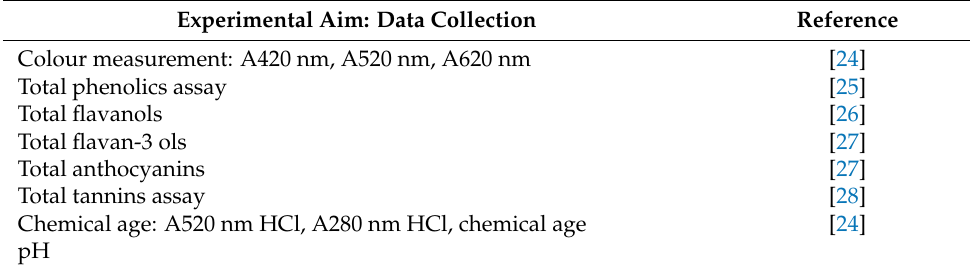
Table 1. Chemical measurements. Experimental Aim: Data